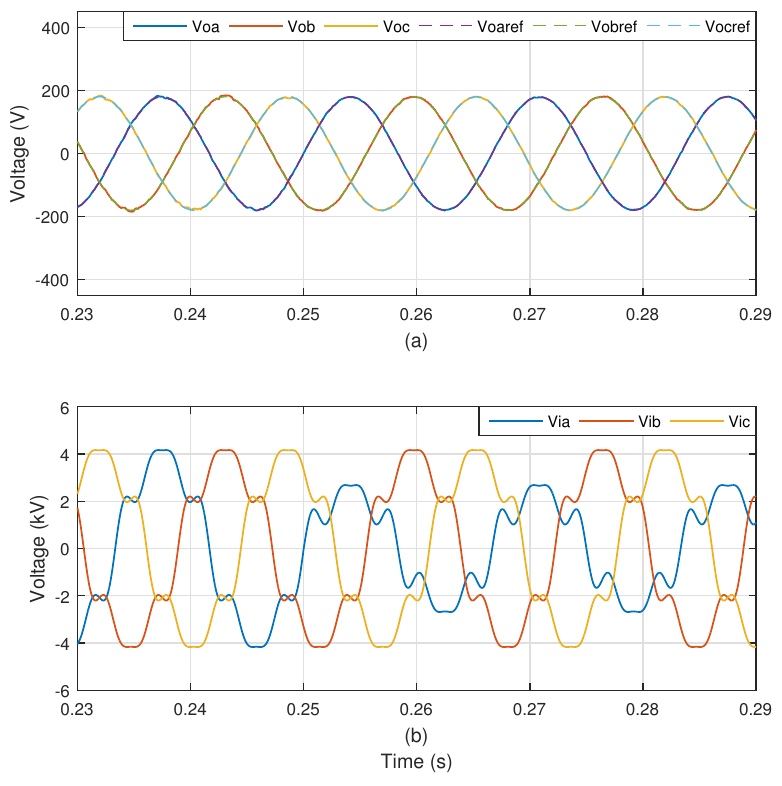
Figure 13. AC-AC 3 × 3 DMC operation. ( a ) Output voltage and ( b ) distorted and unbalanced input